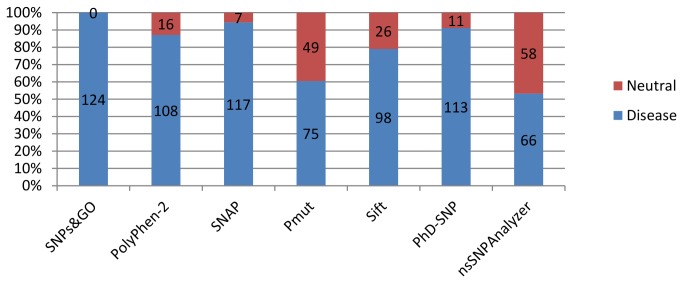
Mutations designated as neutral and non-neutral by the algorithm.Blue bars show the total number of mutations classified as responsible for the disease, while the red bars show the total number of mutations considered neutral.